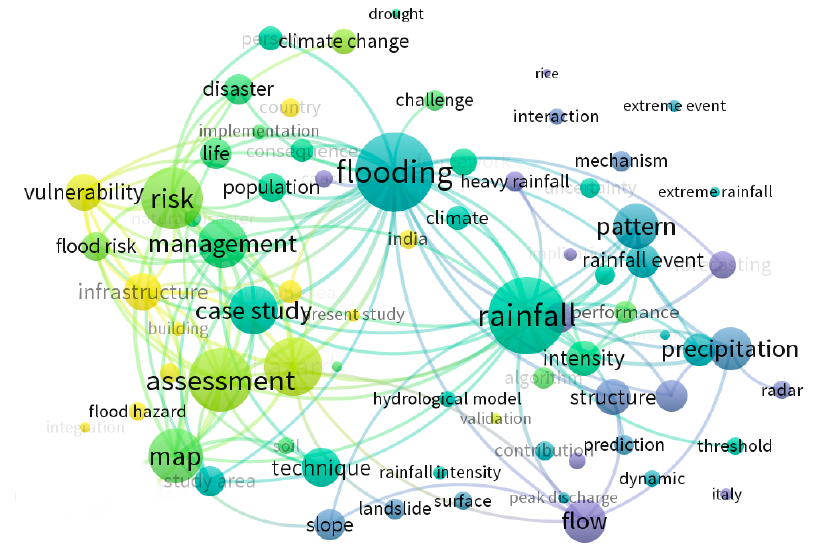
Figure 9. Keyword co-occurrence analysis tab